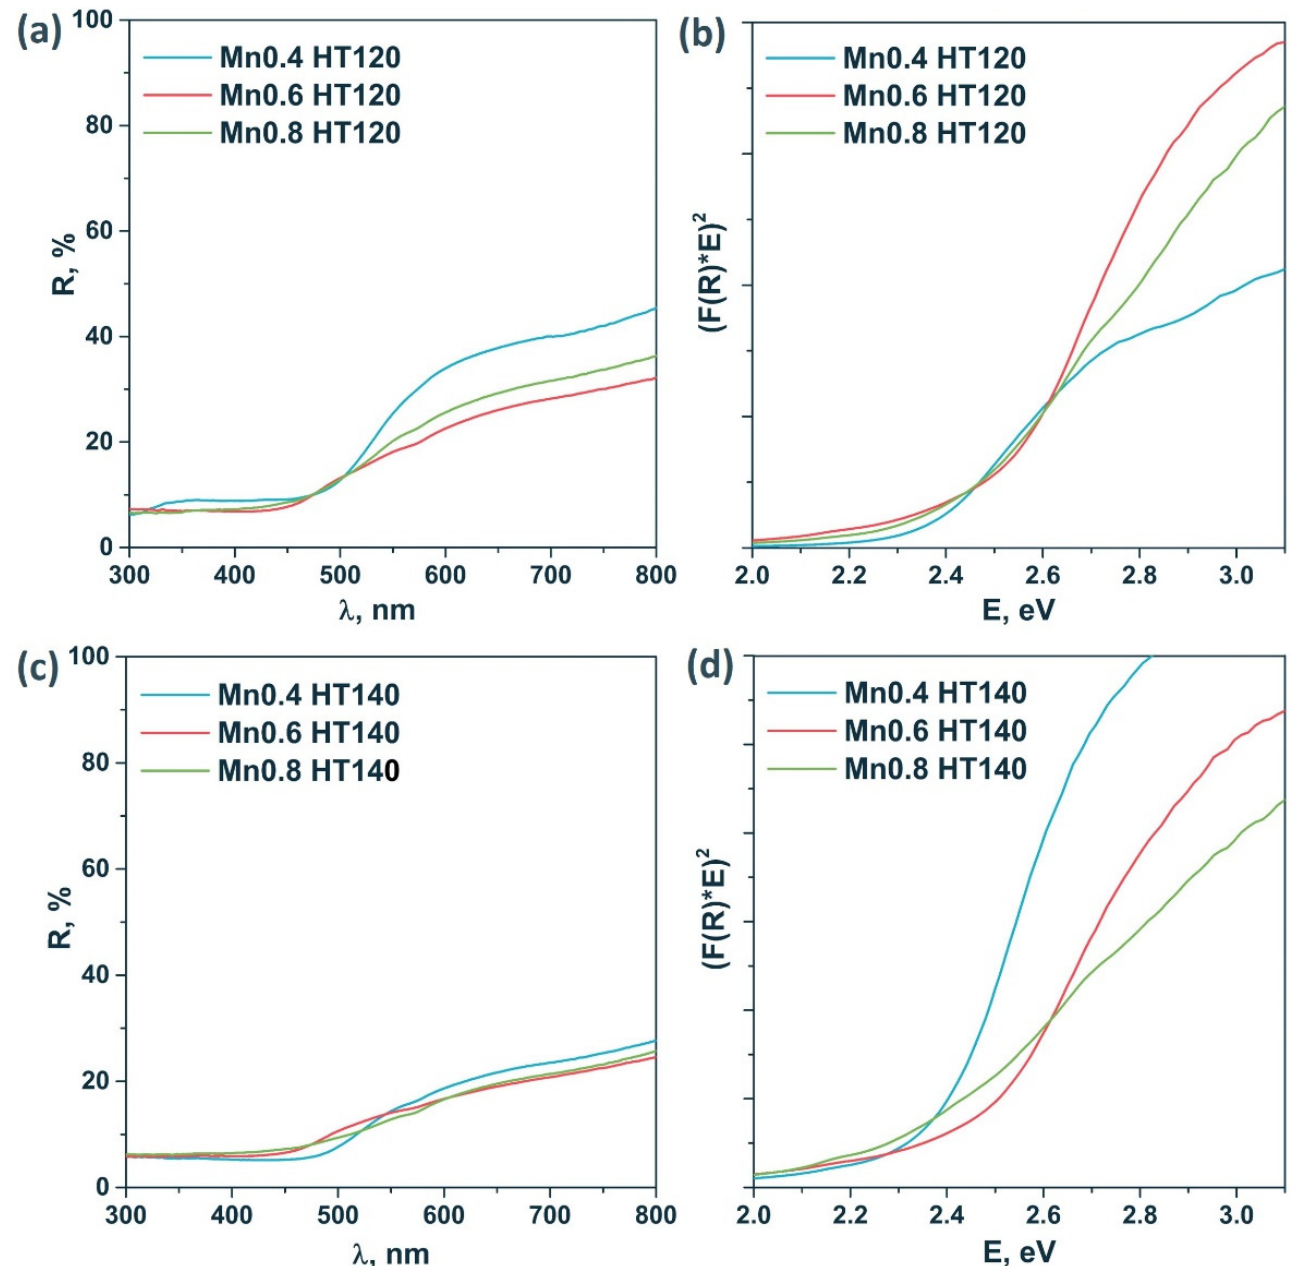
Figure 3. Diffuse reflectance spectra ( a , c ) and Tauc’s plot ( b , d ) of the sample series Cd 1 − x Mn x S HT120 and Cd 1 − x Mn x S HT140.